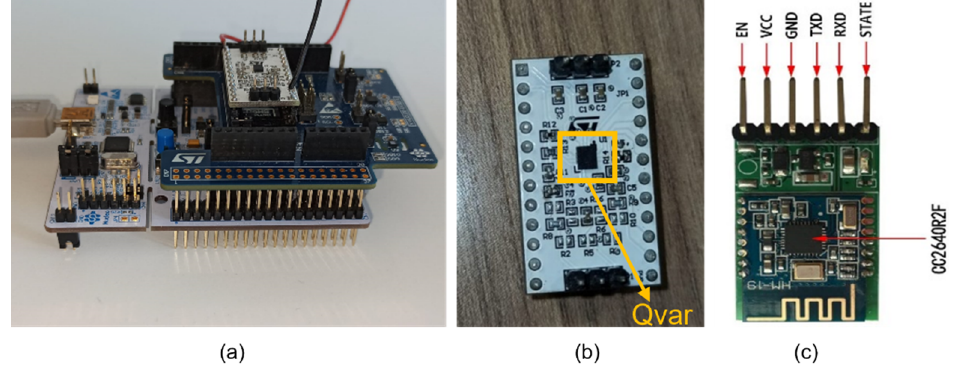
Figure 1. ( a ) The Nucleo L476RG + IKS01A1, ( b ) the ST-Qvar board, and ( c ) the Bluetooth